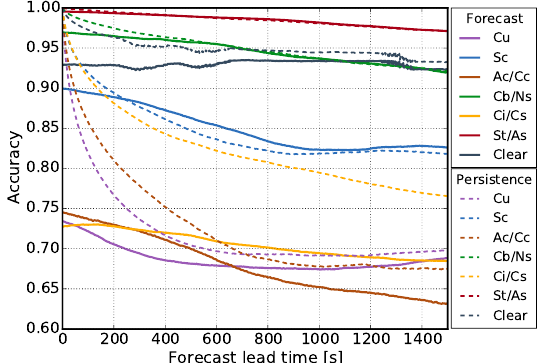
Figure 12. Average accuracy of all stations depending on the fore- cast horizon and the predominant cloud conditions. Solid lines rep- resent the sky imager forecasts, while dashed lines show persistence